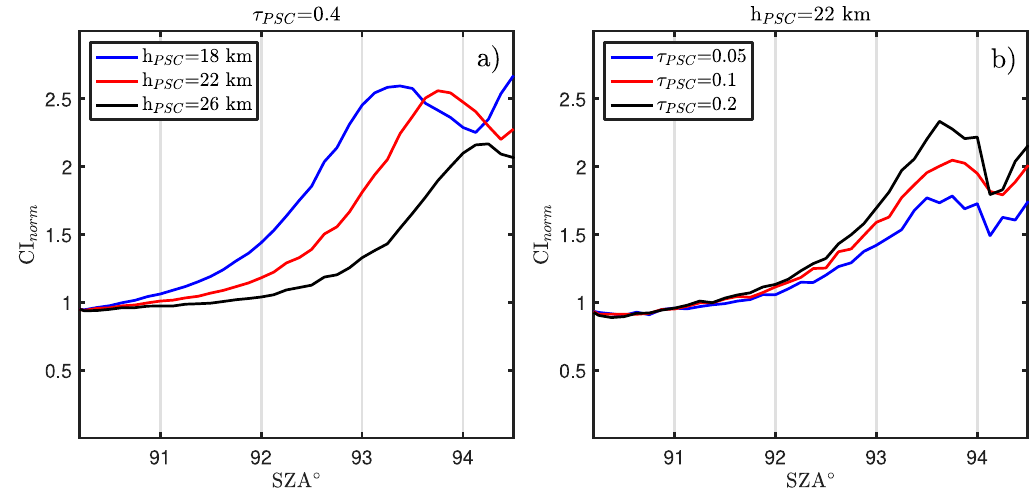
Figure 2. ( a ) Simulated color index during twilight for a cloud opacity of τ PSC = 0.4 and cloud altitude h PSC = 18, 22, and 26 km, ( b ) Same as left panel but for h PSC = 22 km and τ PSC = 0.05, 0.1, and 0.2.